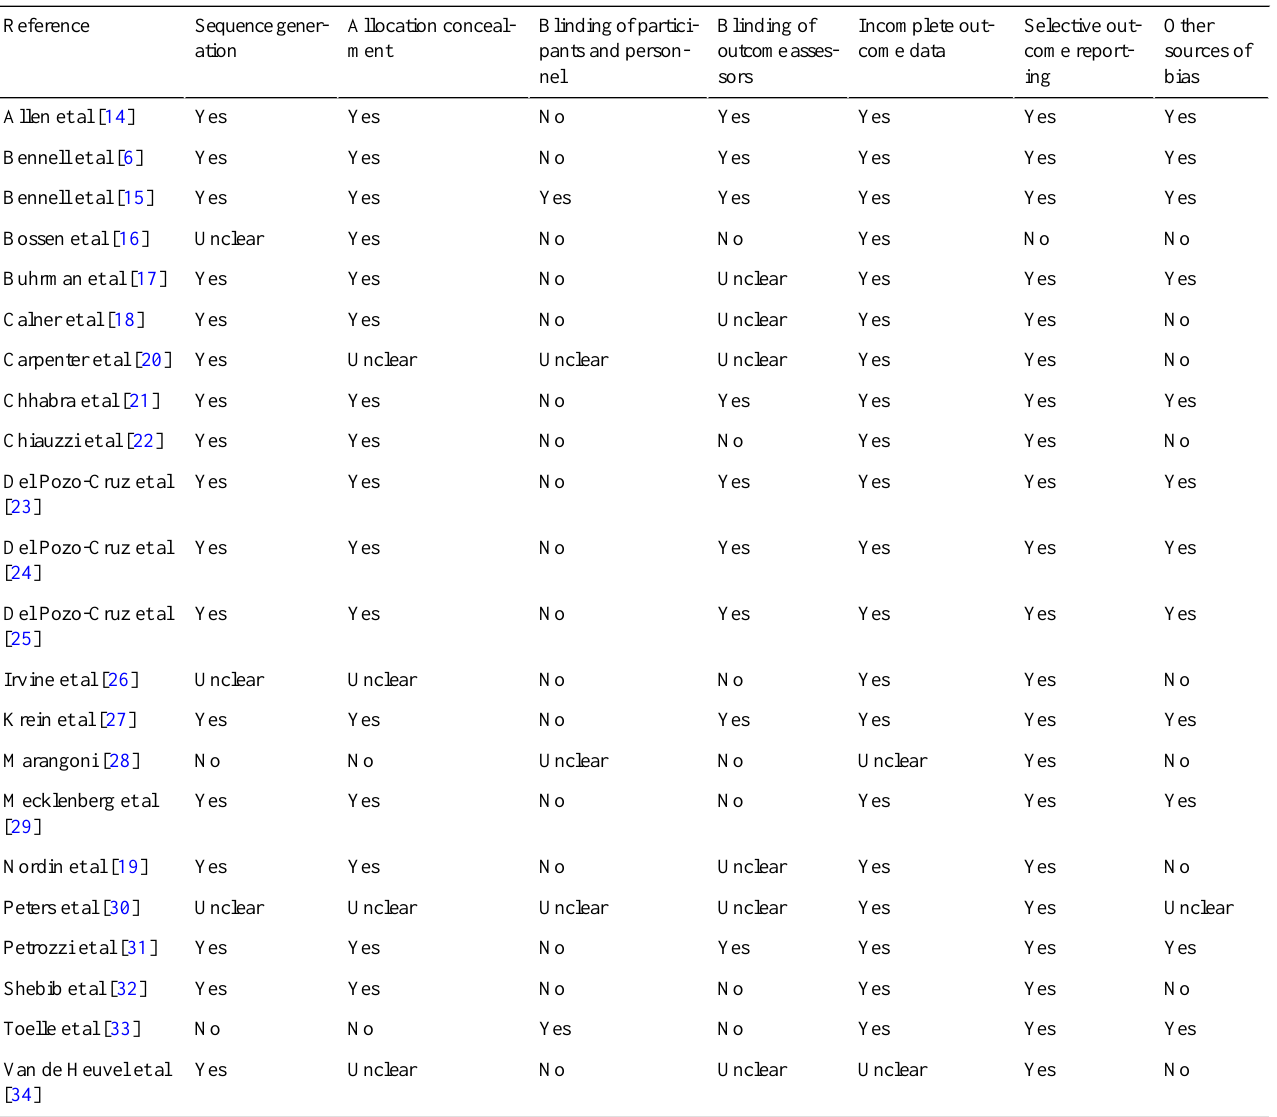
Table 2. Modified Cochrane collaboration tool for assessing risk of bias (For all domains, if reported Yes, this would indicate a low risk of bias, No would indicate a high risk of bias, and Unclear would indicate an unclear risk of